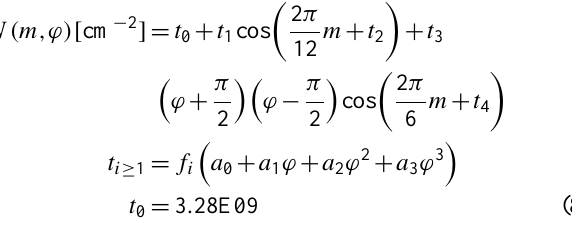
Fig. 7. Intercomparison of Na column climatologies measured in the 30°-50°latitude band. Blue circles: GOMOS data (2002-2008) and associated error bars; blue line: least-squares polynomial fit for all GOMOS data; red line: Fort Collins (41° N) lidar climatology (1990-1999); black line: Fort Collins lidar climatology (2002-2006) restricted to local time periods corresponding to GOMOS observations; green line: OSIRIS measurements (2003-2004) from Gumbel et al. (2007).